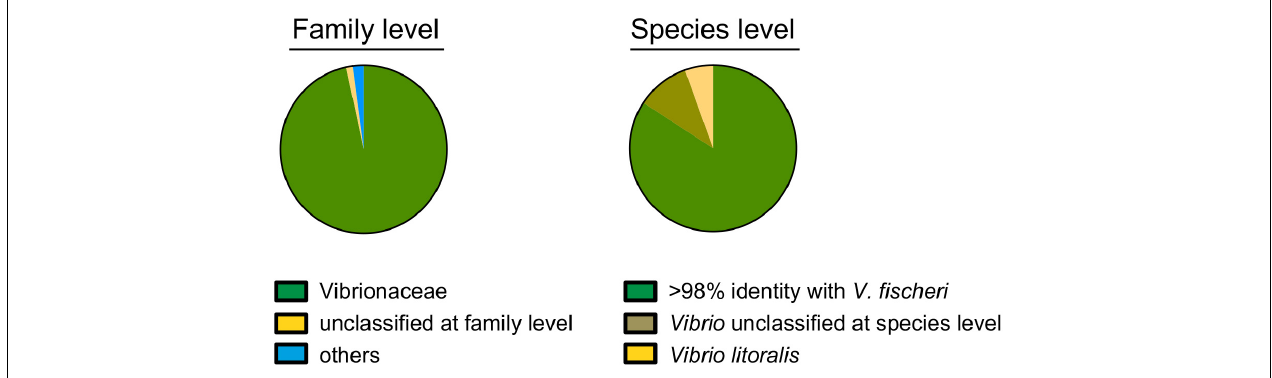
FIGURE 1 | Identification of the bacterial population within a symbiotic light organ at the family (left) and species (right) levels, based on the sequence of the V3-V4 regions of the 16S ribosomal RNA gene. Of the 176,118 total reads, 173,915 (99%) and 152,745 (87%) could be assigned to a family or species,